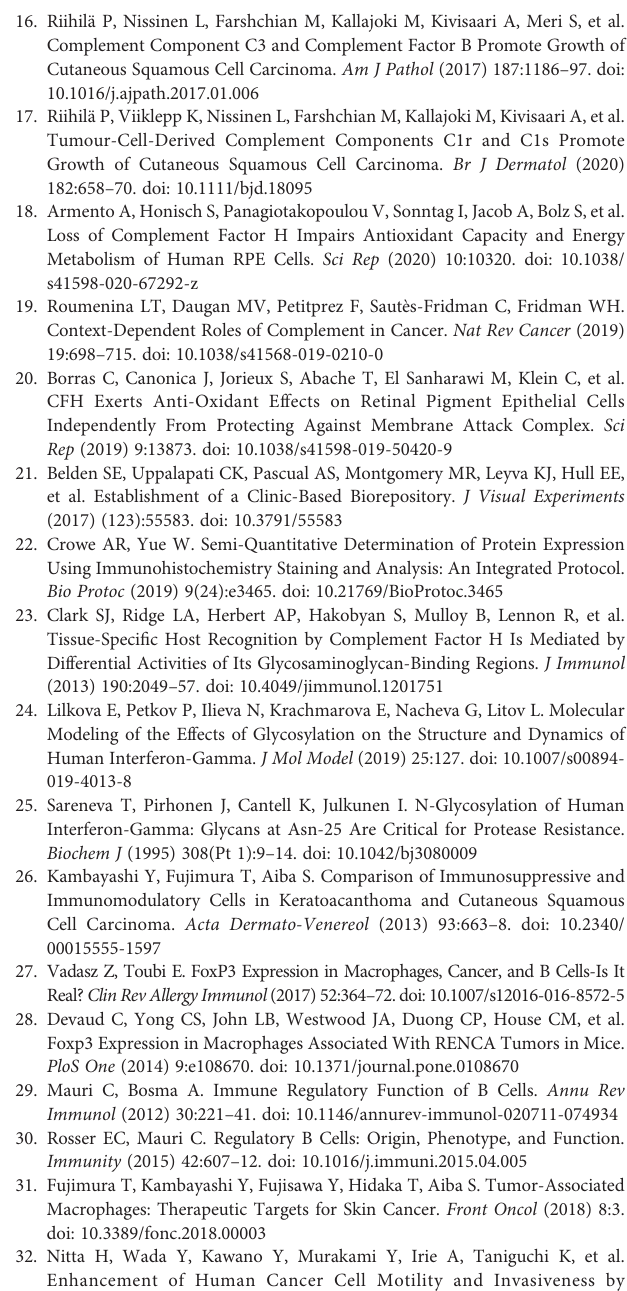
Supplementary Figure 6 | FOXP3 in Advanced cSCC Samples by IHC. Additional images at 400x magni fi cation of advanced cSCC (formalin fi xed) array slides. Sections were labeled with a rabbit monoclonal anti-FOXP3 (Cell Marque) and stained with an HRP-conjugated secondary antibody and DAB stain. Mayer ’ s Hematoxylin was used as a counterstain (nuclei). Supplementary Figure 7 | Expression of Complement Receptors in GTEx Datasets. Analysis of unpaired GTEx data from sun exposed vs non-sun exposed shows that sun exposed tissue has a signi fi cant increase in mRNA expression of C3aR (p=0.0014) and C5aR2 (p=0.0005) compared to non-sun exposed skin. mRNA expression of C5aR1 was not signi fi cantly different in this analysis